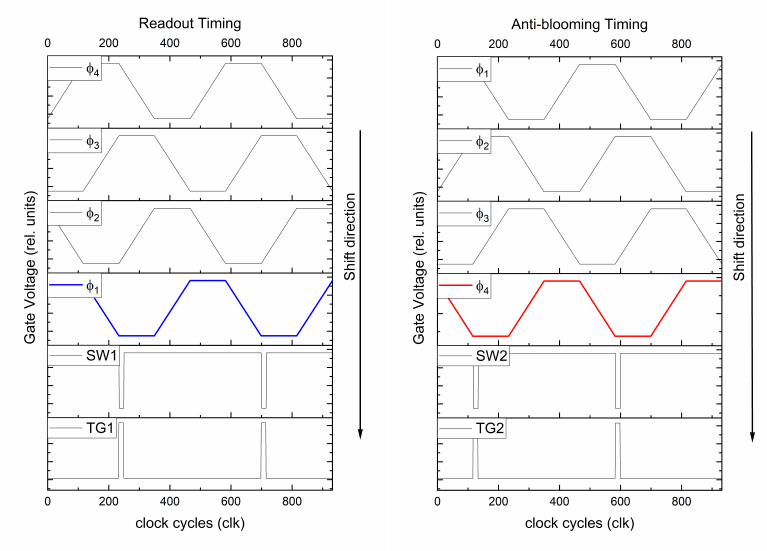
Figure 3. Design of the double source follower circuitry.